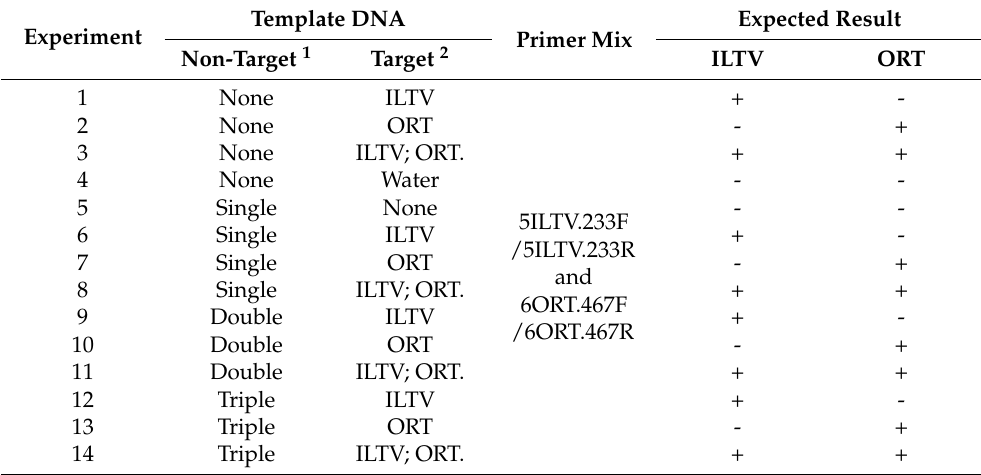
1 There are six non-target pathogens: fowl pox virus (FWPV), Mycoplasma gallisepticum (MG), Mycoplasma synoviae (MS), Avibacterium paragallinarum (APG), Avian pathogenic Escherichia coli (APEC), and Pasteurella multocida (PM). They are divided into three groups of viruses (FWPV), mycoplasma (MG and MS), and bacteria (APG, APEC, and PM). Single DNA contains either FWPV, MG, MS, APG, APEC, or PM mixes with the target DNA(s). Double DNA contains either virus mycoplasma, virus bacteria, or mycoplasma bacteria mixes with the target DNA(s). Triple DNA contains virus mycoplasma–bacteria mixes with target DNA(s). 2 Extracted DNA from infectious